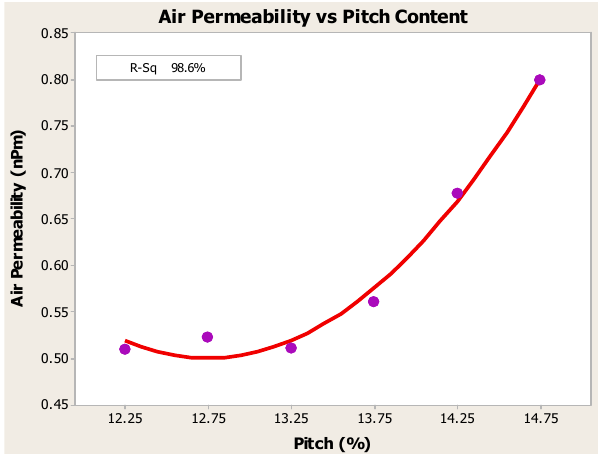
Figure 9. Air permeability vs. pitch content.